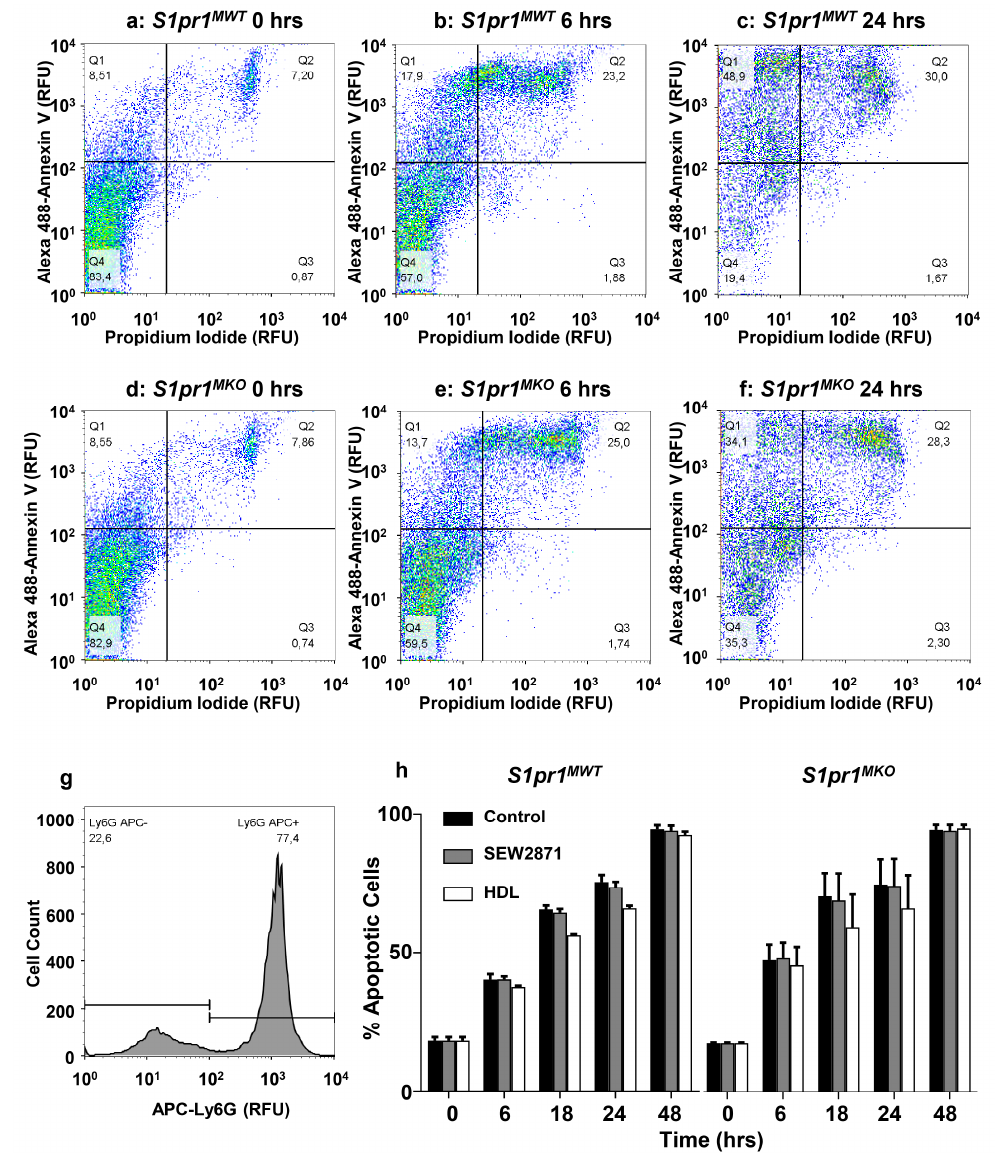
Figure 8. Apoptosis of neutrophils from S1pr1 MKO or S1pr1 MWT mice is unaffected by HDL